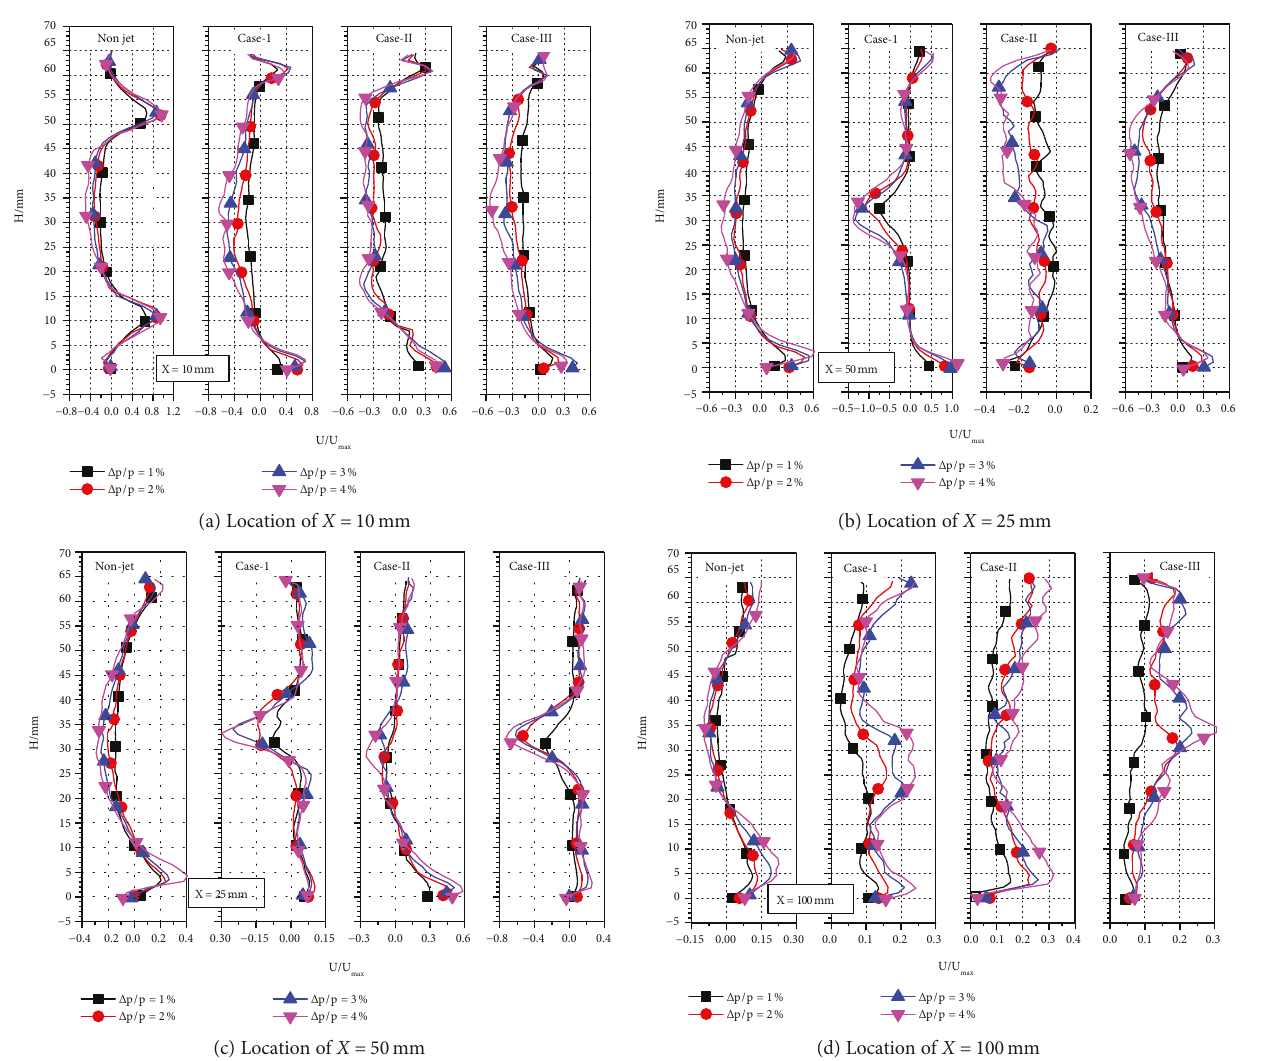
Figure 4: Axial velocity along the Y direction at di ff erent axial locations on the Z = 0